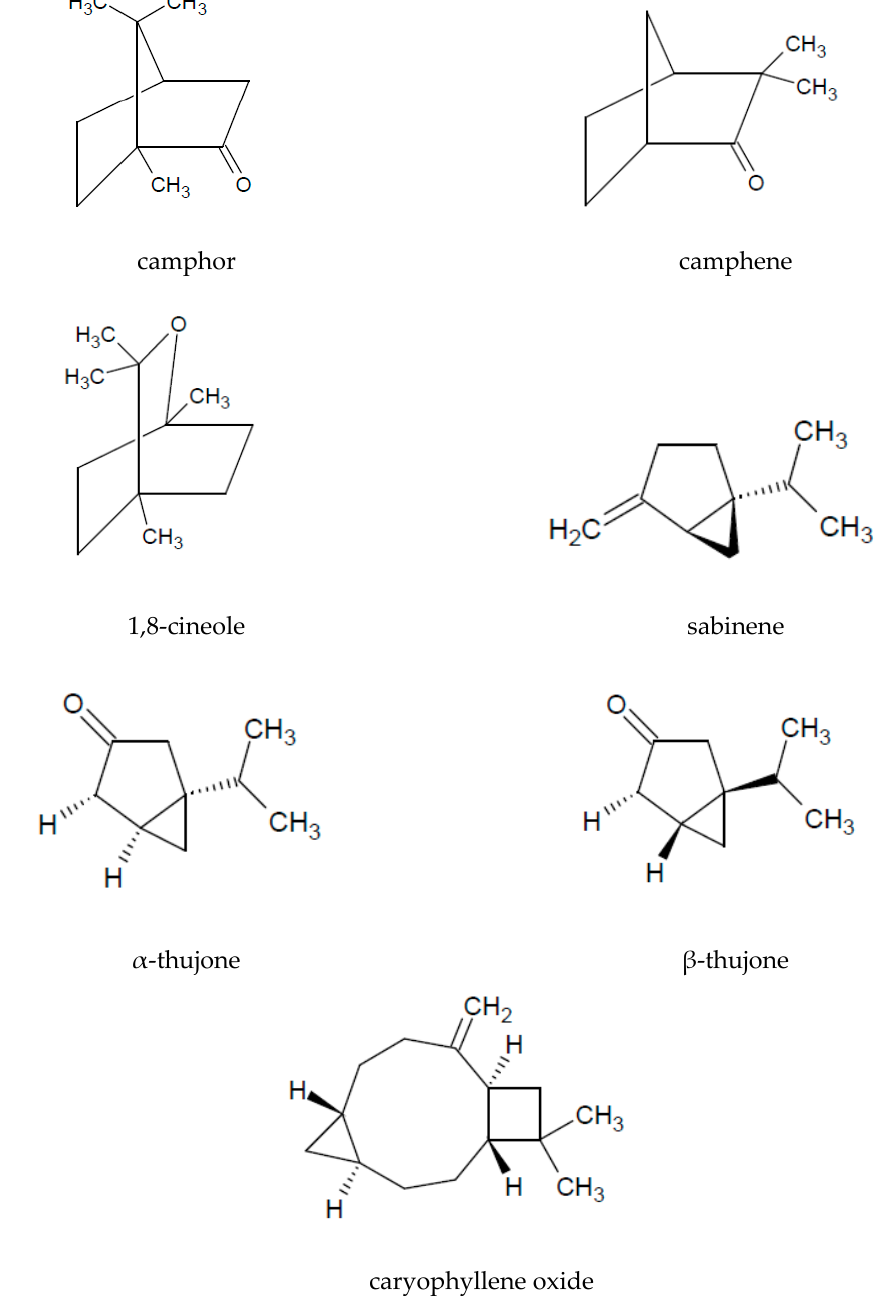
Figure 2. The chemical structure of volatile compounds characteristic of the essential oil of A. vulgaris herb.